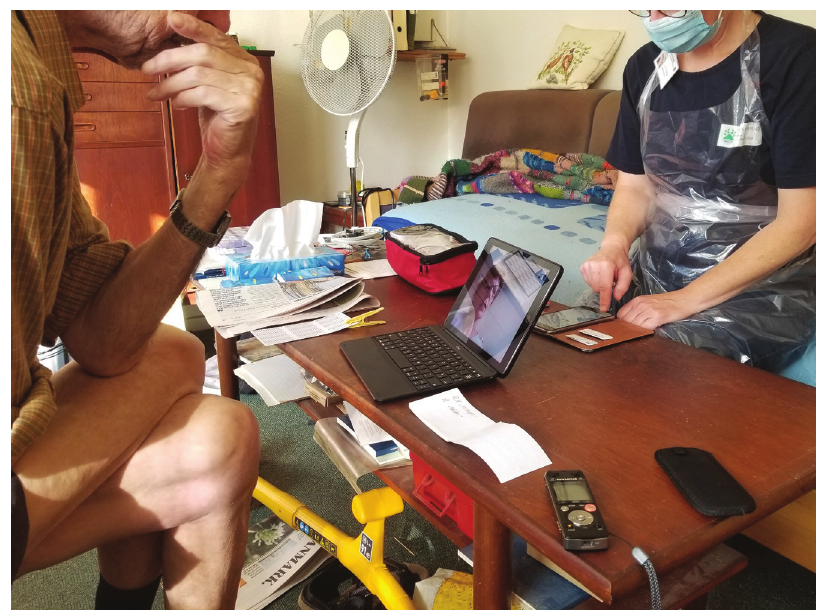
Figure 1. Lars, the home nurse, and the cardiac nurse during their video